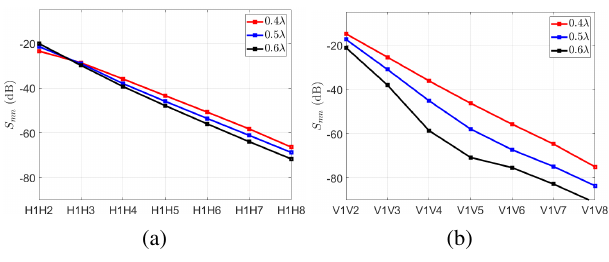
FIGURE 8: Mutual coupling effects for (a) H and (b) V Ports for 2X20 Array at 2.8 GHz at d=0.4 λ , d=0.5 λ and d=0.6